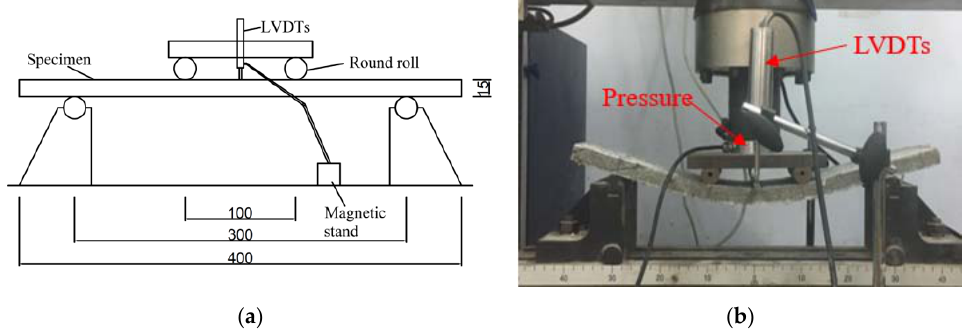
Figure 4. ( a ) Schematic diagram and ( b ) loading diagram of four-point flexural test.